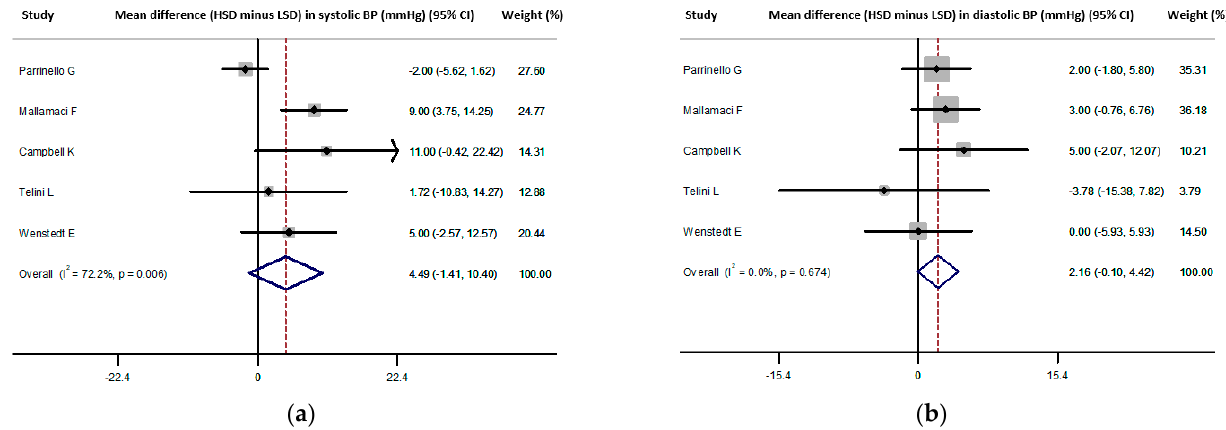
Figure 6. ( a ) Forest plot of the mean difference in systolic blood pressure (SBP) levels for high sodium dose (HSD) versus low sodium dose (LSD) as defined per study [27,37,40–42]. ( b ) Forest plot of the mean difference in diastolic blood pressure (DBP) levels for high sodium dose (HSD) versus low sodium dose (LSD) as defined per study [27,37,40–42].